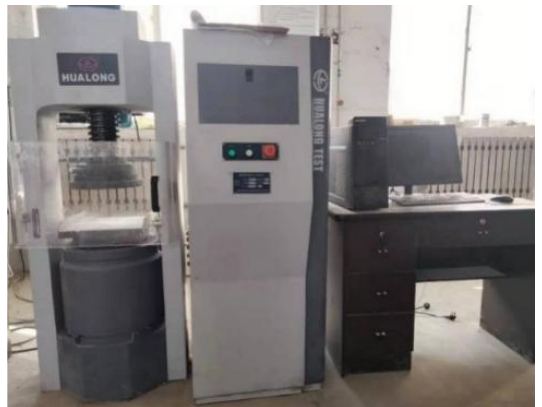
Figure 3. The testing apparatus of the cube compressive and splitting tensile test.